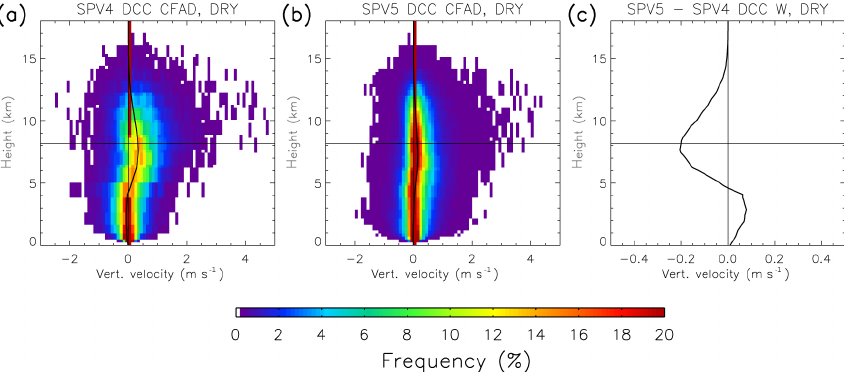
Figure 7. (a, b) CFADs of DCC vertical updraft velocity from (a) SPV4 and (b) SPV5. The format is the same as for the reflectivity CFADs. Note that SPV4 and SPG4 vertical velocities (not shown) are identical. (c) The difference between SPV4 and SPV5 mean vertical velocity